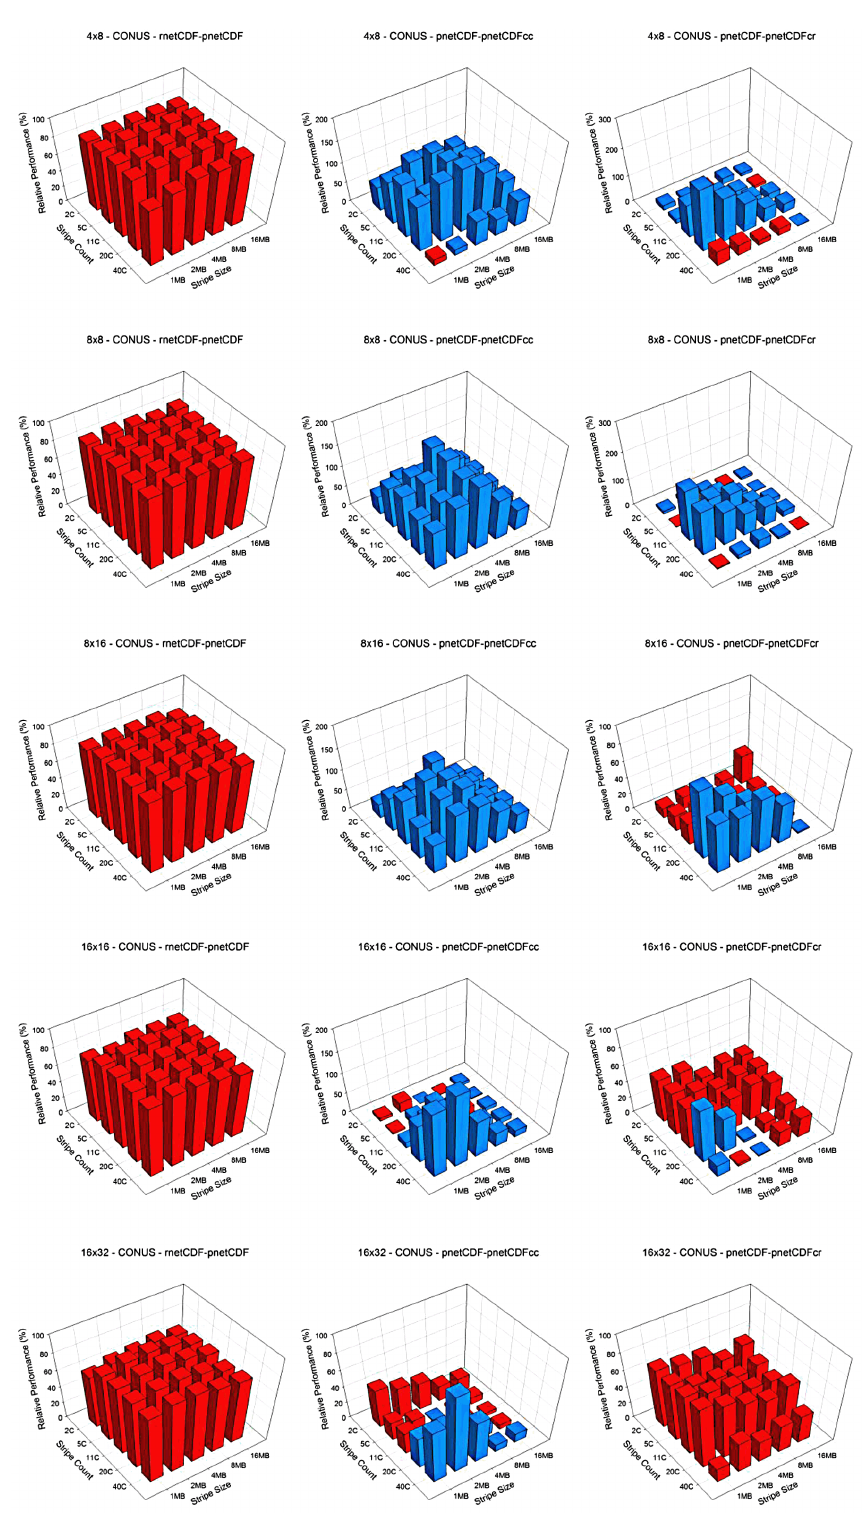
Figure 7. Relative I/O performance of pnetCDF to rnetCDF, and pnetCDFcc and pnetCDFcr to pnetCDF on the CONUS domain with 4 × 8, 8 × 8, 8 × 16, 16 × 16, and 16 × 32 processor configurations from Kraken. Red color denotes positive value in relative performance while blue color denotes negative value in relative